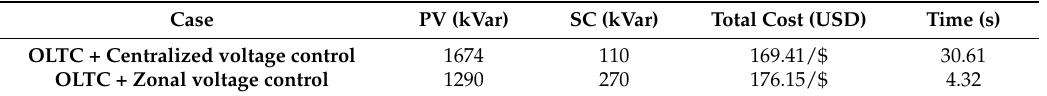
Table 3. Comparison case 2.